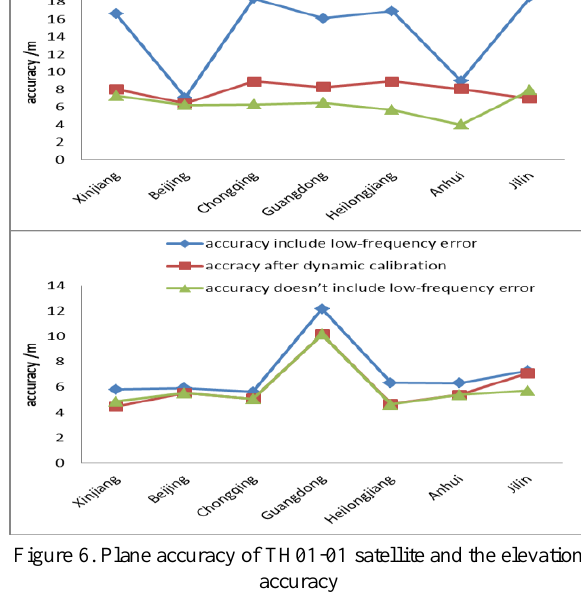
Figure 6. Plane accuracy of TH01-01 satellite and the elevation accuracy